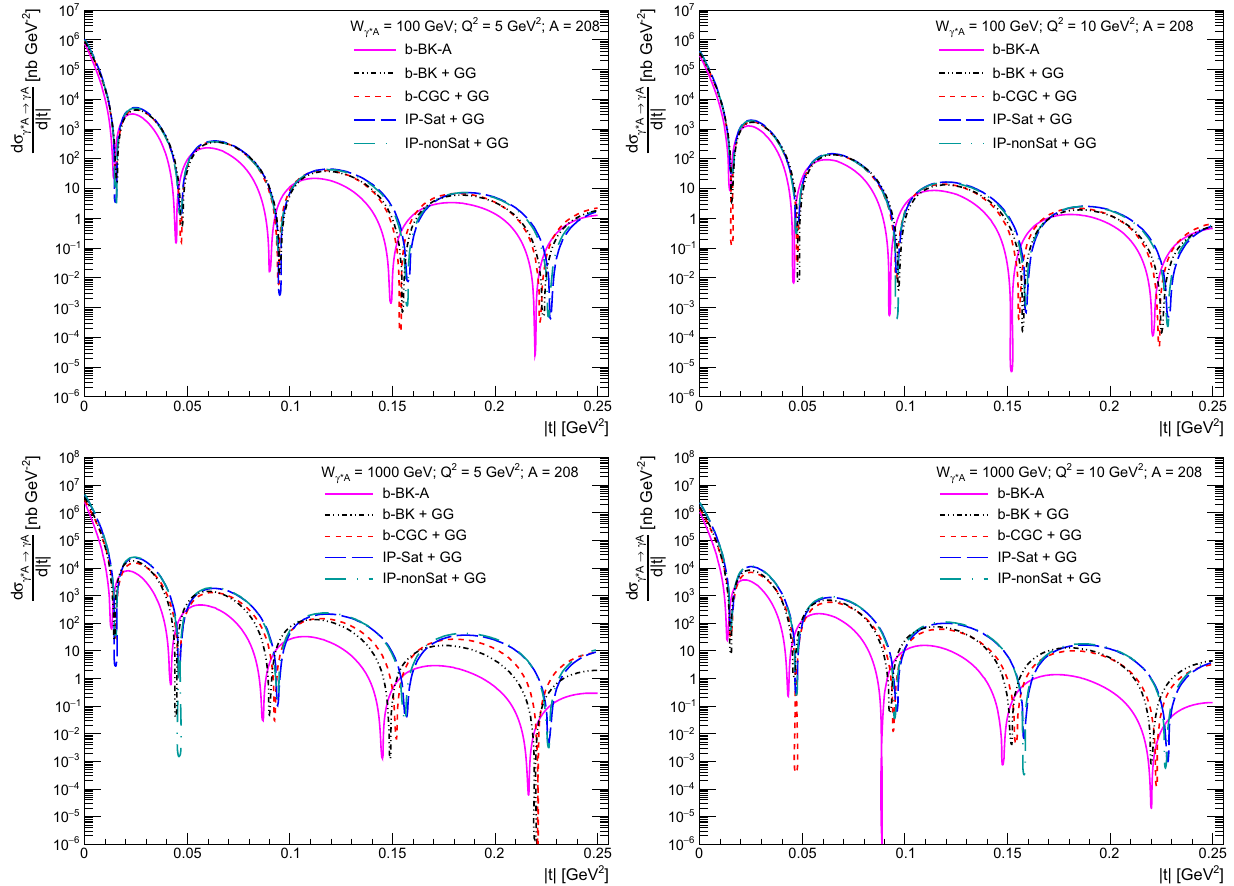
Fig. 7 Predictions for the t -distribution of the nuclear DVCS process at the EIC (upper panels) and LHeC (lower panels) derived considering distinct models for the dipole-nucleus scattering amplitude, A = Pb , and different values of the photon